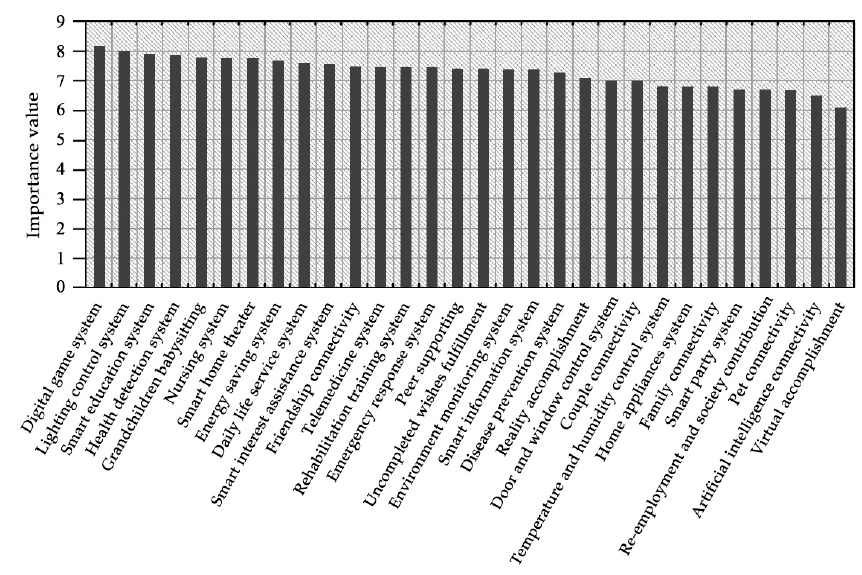
Figure 4. The importance distribution in the Kano Model.